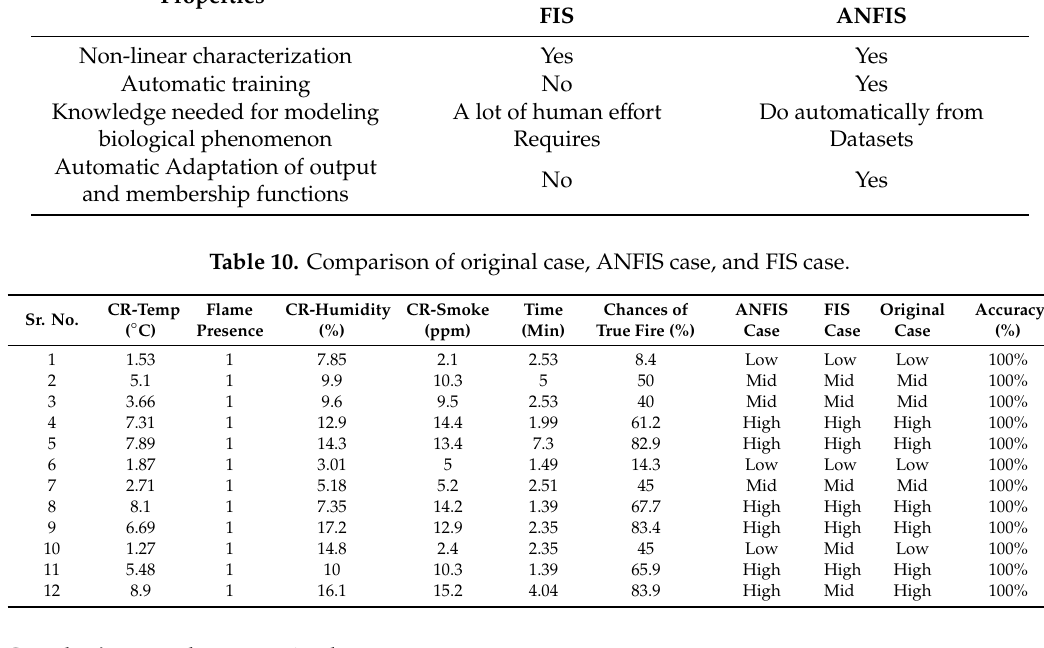
Table 9. Comparison of two related technologies FIS and ANFIS.